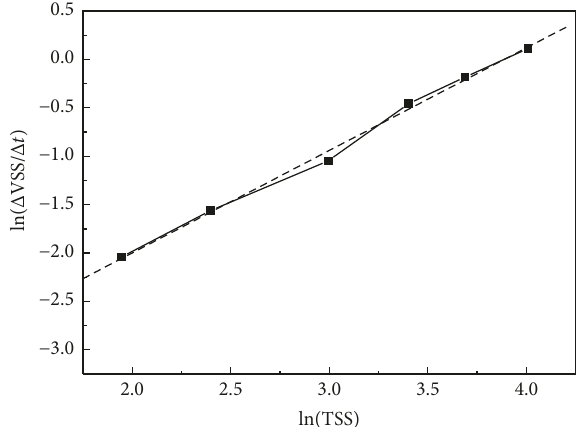
Figure 9: The relationship between VSS degradation rate and stirring rate. — ◼ — regression coefficient of 0.9872 for 𝑞 ; ------ ln (Δ VSS /Δ𝑡) = 0.5637 − 0.1618 ln 𝑉